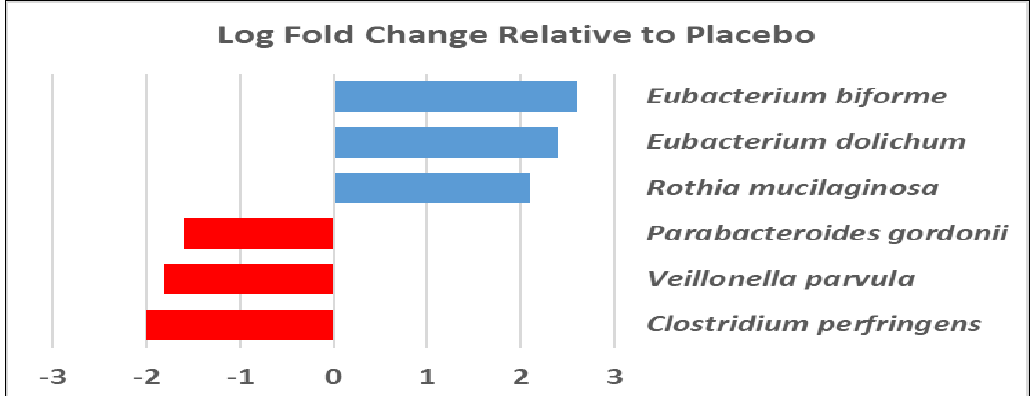
Figure 4. Using a negative binomial generalized linear model (GLM) (EdgeR), we identified several taxa that significantly ( q < 0.10) differed from placebo levels after 28days of phage consumption. Red bars represent taxa reduced with phage treatment, and blue bars represent taxa that were increased.